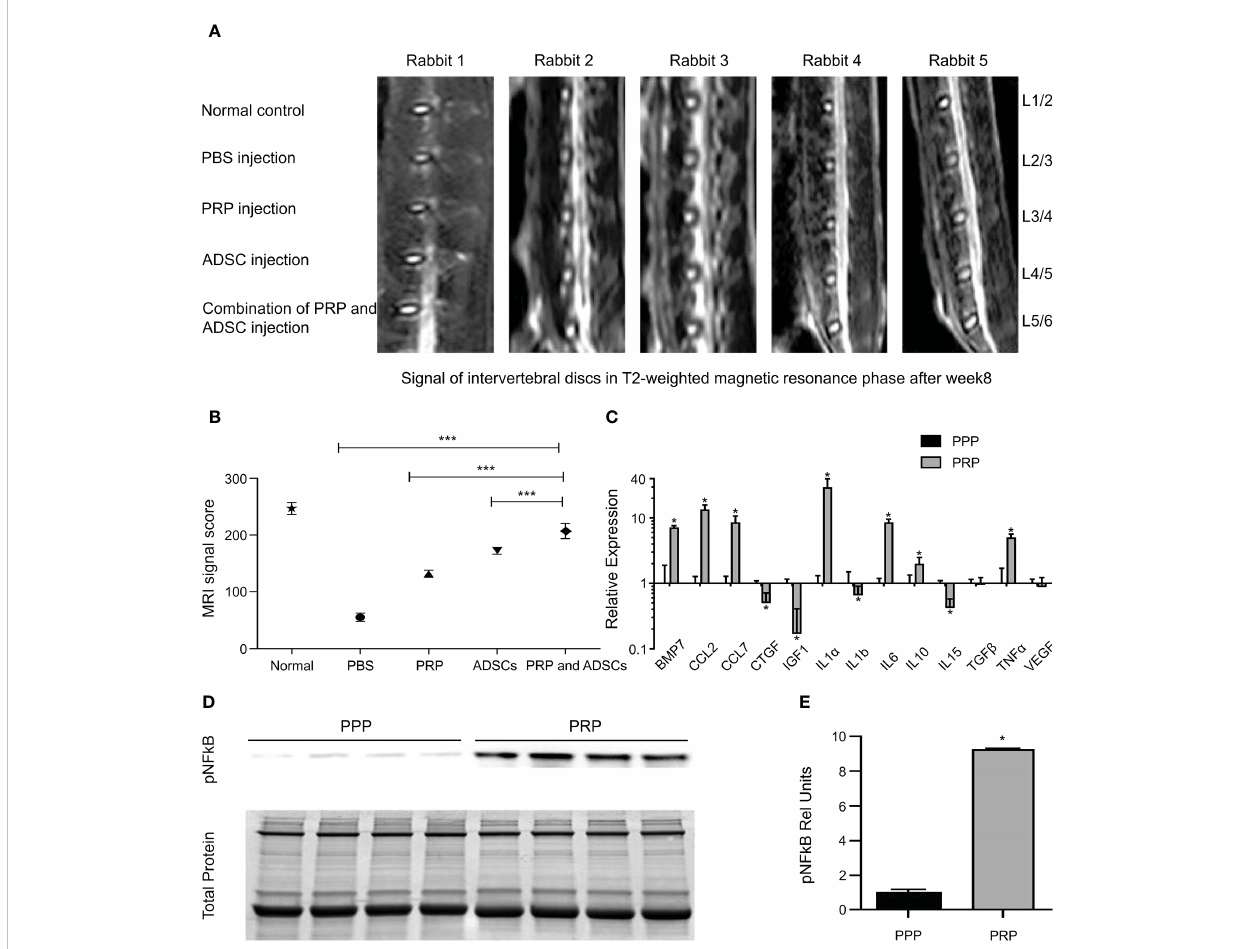
FIGURE 6 (A) The disc signals in magnetic resonance T2-weighted image in the group of ADSC-combined PRP showed higher signal strength than the other groups. (B) PRP combination with ADSCs has the best effect in reversing degeneration. (C) Gene expression of growth factor and cytokine transcripts from PPP or PRP treated tendon fi broblasts. (D) Immunoblots for phospho NF k B activation from tendon fi broblasts treated with PRP or PPP. (E) Band densitometry analysis for phospho NF k B blots. Reproduced with permission from (111, 112). * P< 0.05, ***